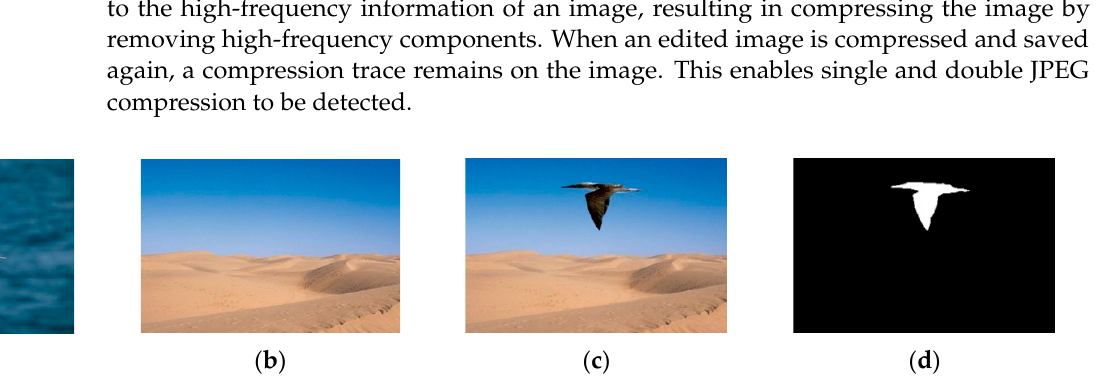
Figure 1. Example of an image-splicing forgery: ( a ) object image; ( b ) target background; ( c ) splicing forgery; ( d ) ground truth for forgery region.